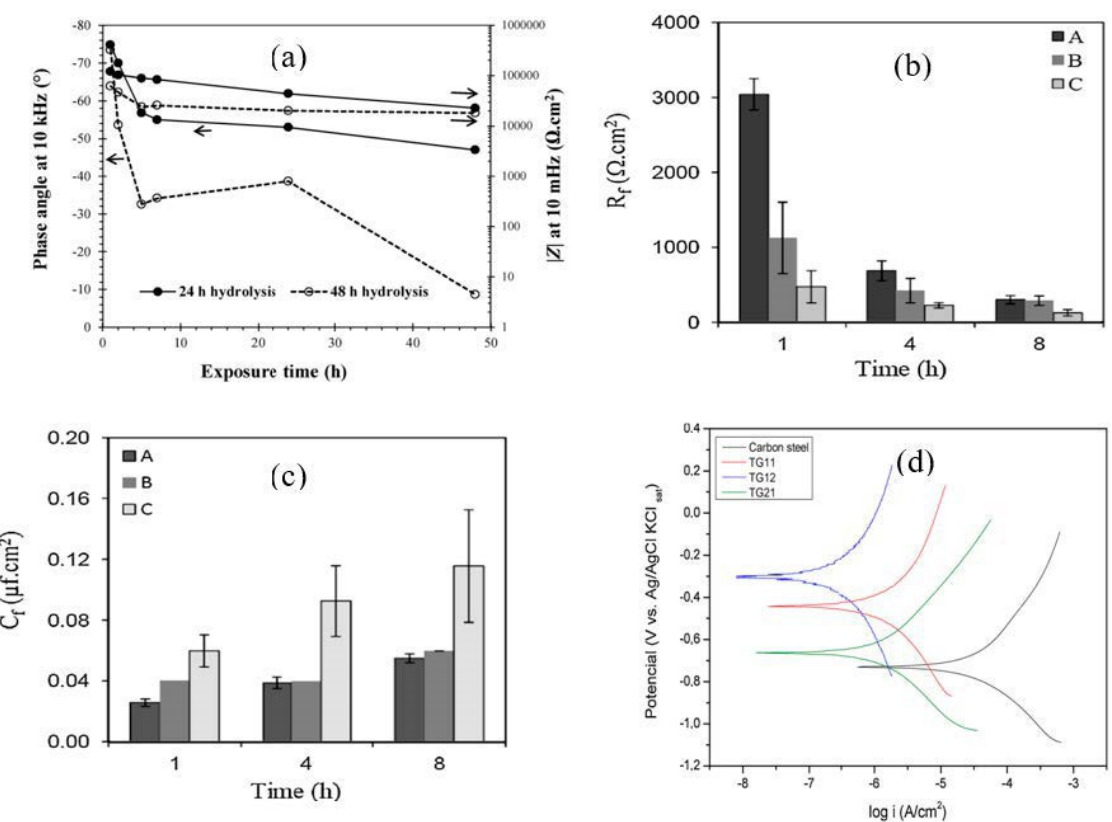
Figure 6. ( a ) The impedance magnitude (|Z|) at low frequency (10 mHz) and phase angle at high frequency (10 kHz) of silane coatings with hydrolysis times of 24 and 48 h [49]. ( b , c ) Evolution of silane film resistance (Rf) and capacitance (Cf) (A: pH 2.8, dipping time 120 s; B: pH 2.8, dipping time 60, pH 2.8, dipping time 30 s) within 8 h of exposure to 0.1 M NaCl solution [50]. ( d ) Potentiodynamic polarization (PDP) of the uncoated substrate and coatings with different molar ratios of 1:1,1:2 and 2:1 of TEOS and GPTMS [51].